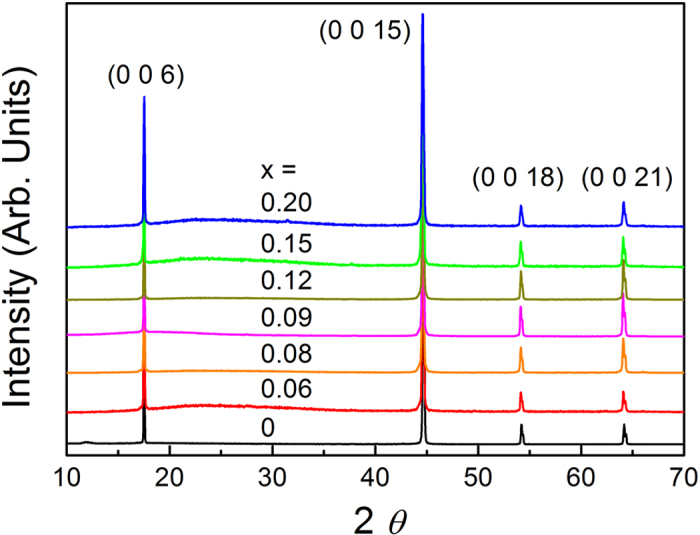
Single-crystal X-ray diffraction patterns for Bi2-xGdxTe3.